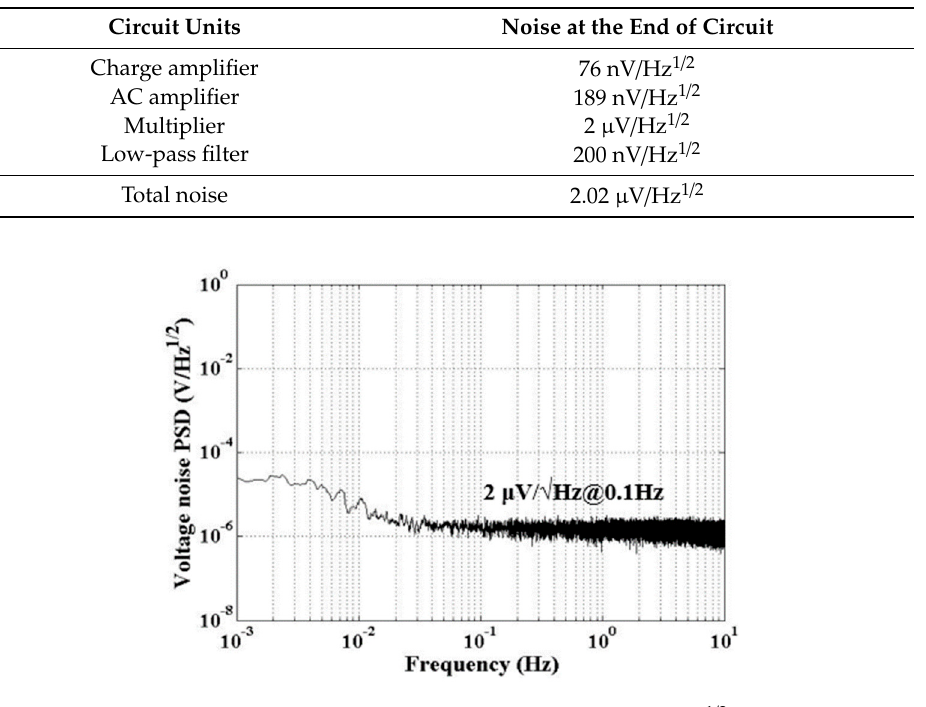
Figure 2. The background noise of capacitive transducer. It is about 2 μ V/Hz 1/2 at 0.1 Hz. The noise is consistent with the theoretical calculation in Table